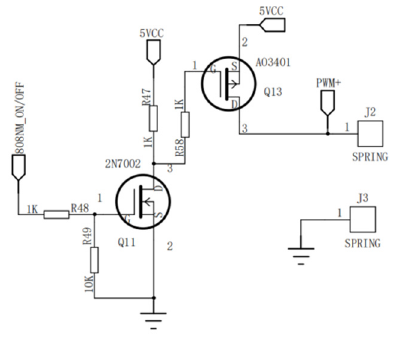
Figure 4. Schematic diagram of the constant current drive module.